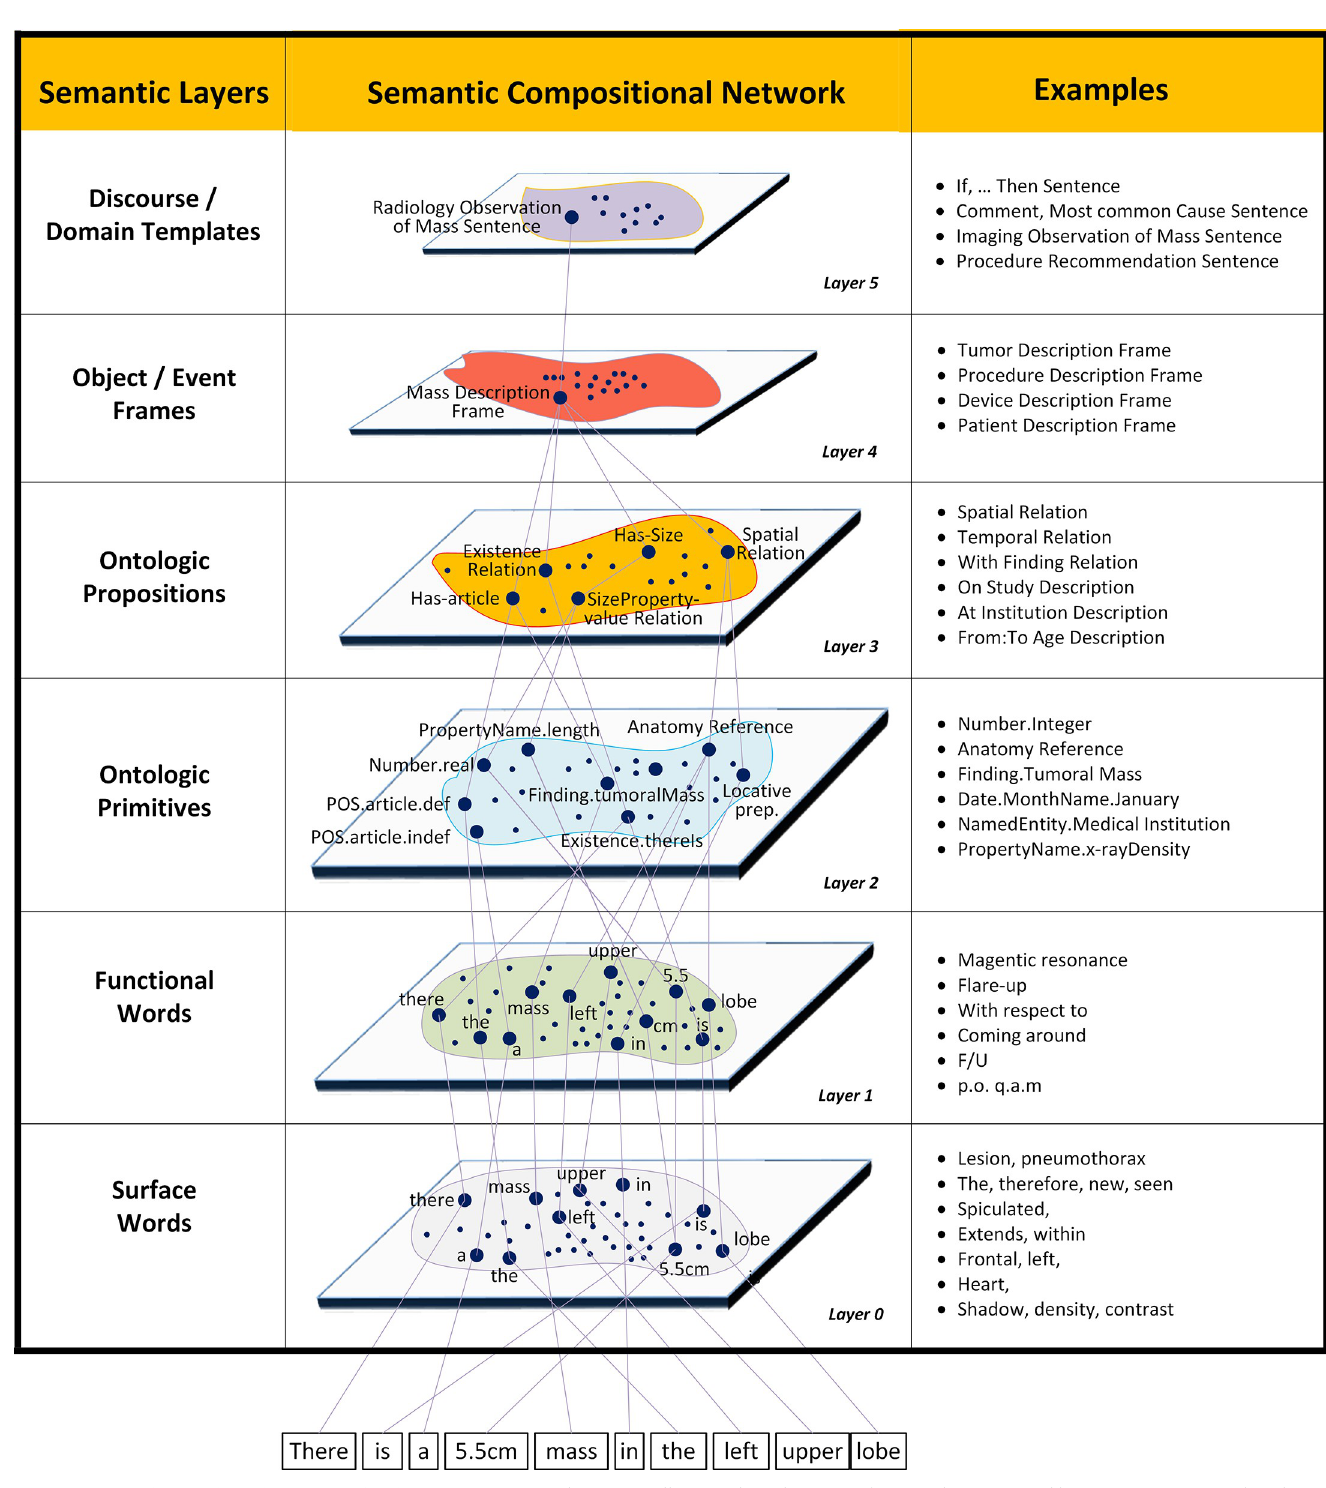
Fig 3. Layers and example node instances for the HSCM. An example sentence illustrates how the input tokens can be interpreted by instantiating network paths through the model. Each plane contains the domain of semantic constituents for the given abstraction level. For visual simplicity, arrows should be assumed to point downward to indicate